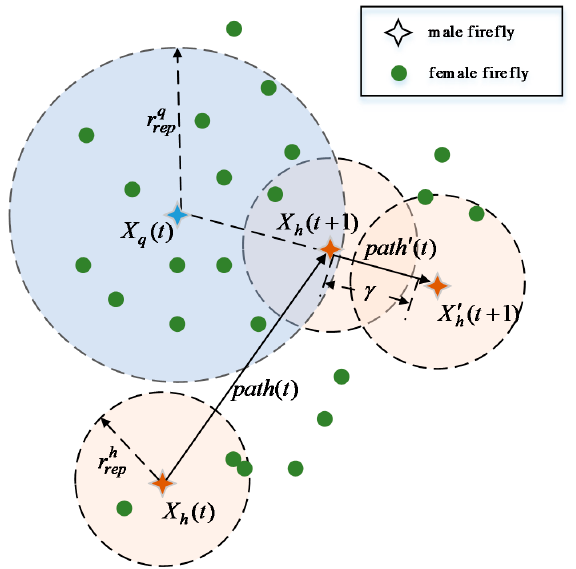
Figure 2. Diagram of the mutually exclusive influence between fireflies.